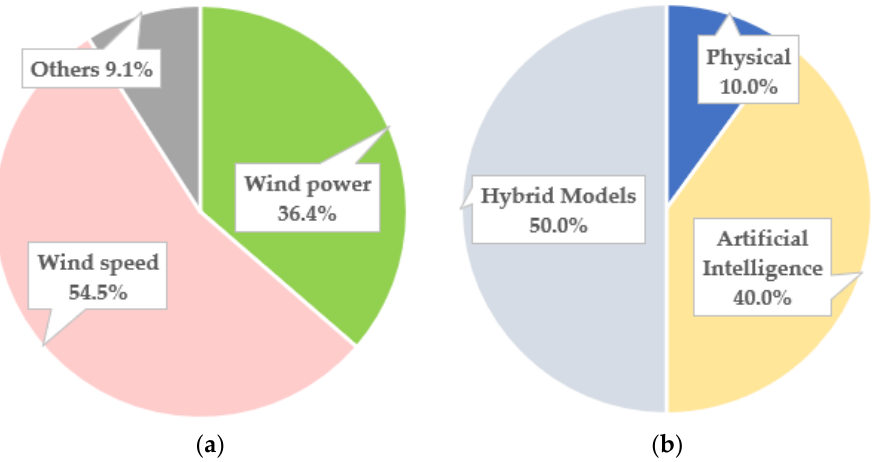
Figure 10. ( a ) Percentage distribution of the forecast objective of medium-term models. ( b ) Percentage distribution of medium-term forecasting methods.